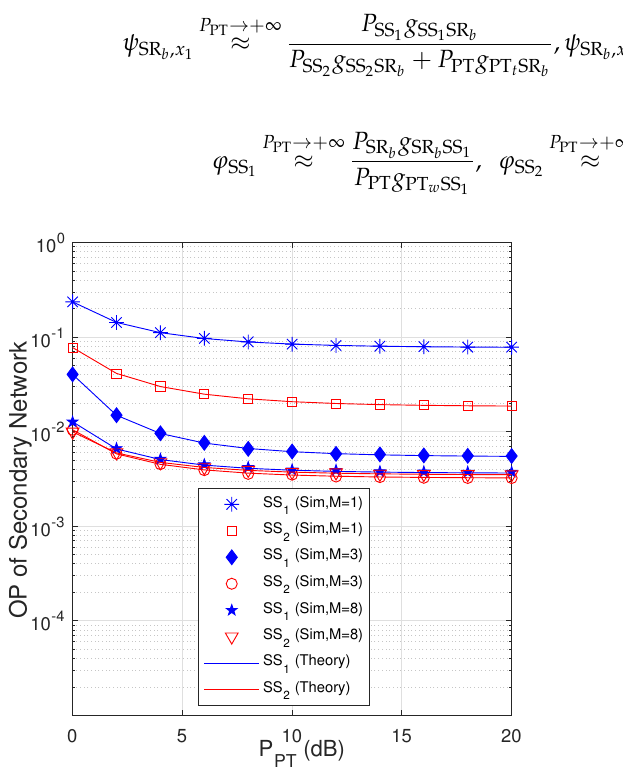
Figure 4. OP of the secondary sources versus P PT (dB) when x R =